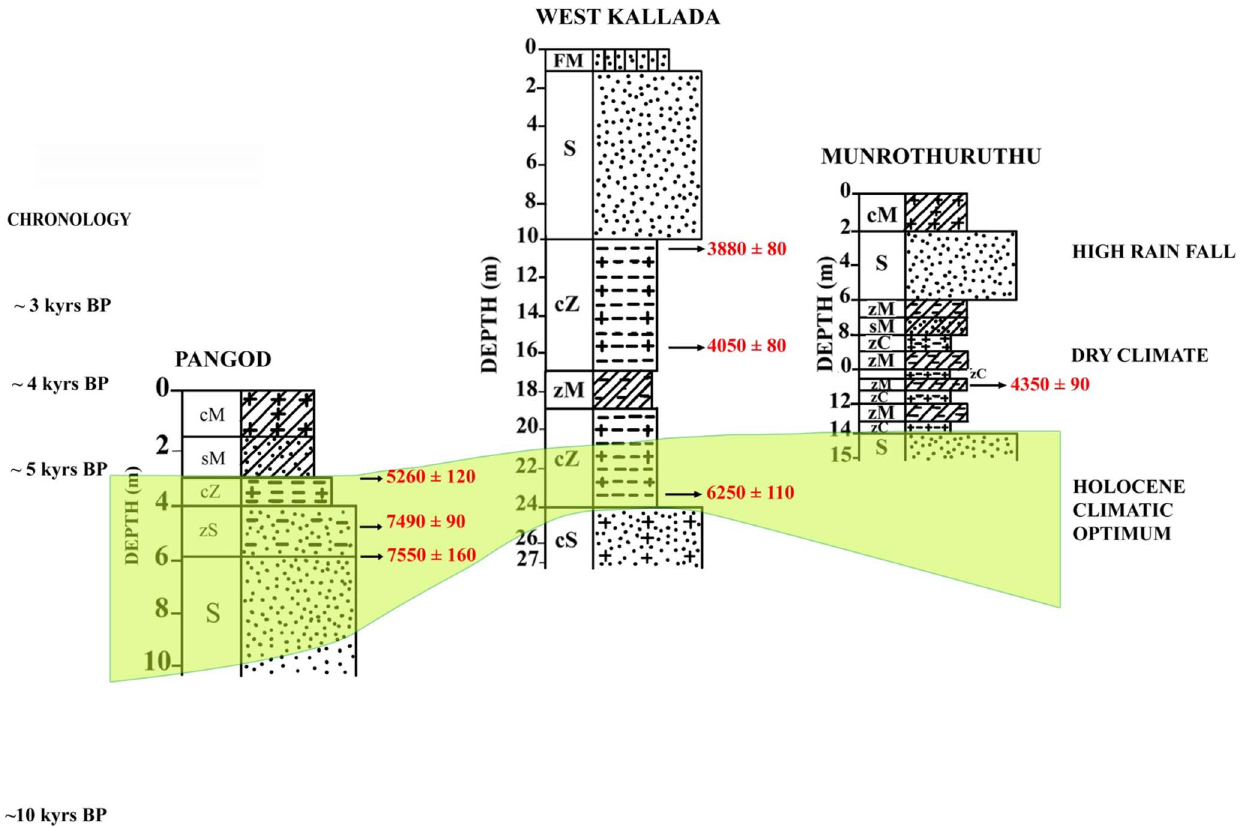
Figure 6. Correlation of Pangod, West Kallada and Munrothuruthu areas showing Holocene Climatic phases.